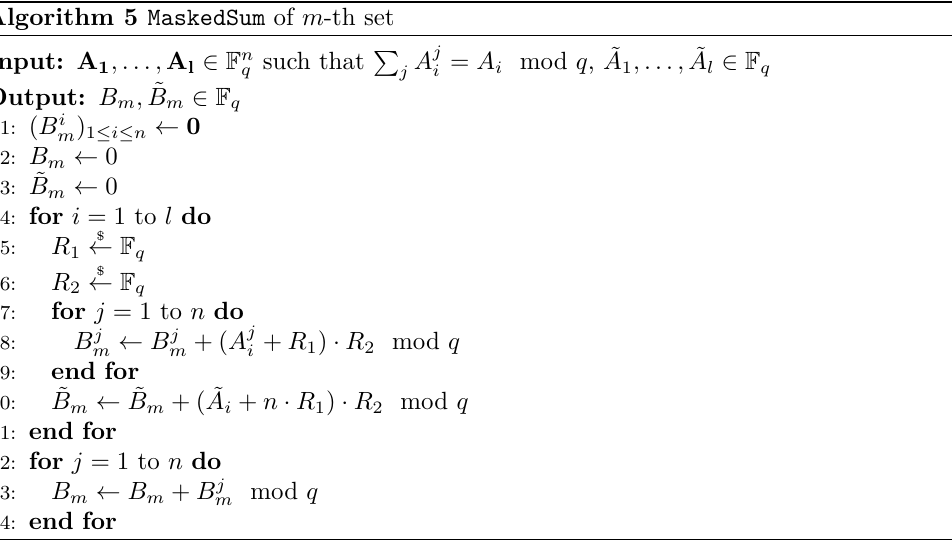
Algorithm 5 MaskedSum of m -th